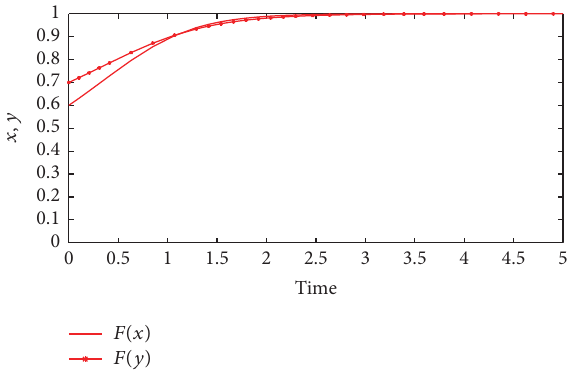
Figure 5: The equilibrium figure after 2nd step game.